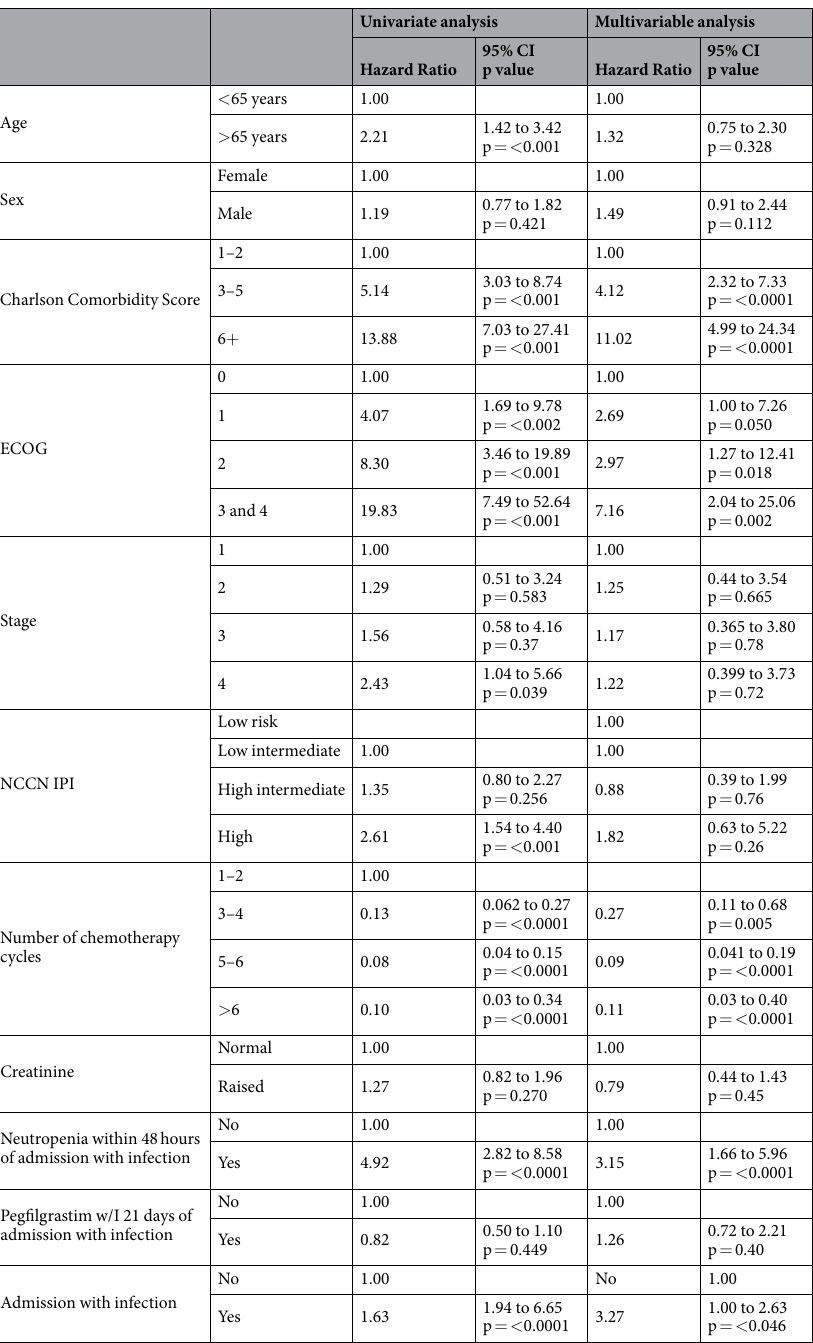
Table 7. Regression analysis of the factors associated with survival in patients who received R-CHOP 21 (n = 286). ECOG = Eastern Cooperative Oncology Group performance status point scale. NCCN- IPI = International Prognostic